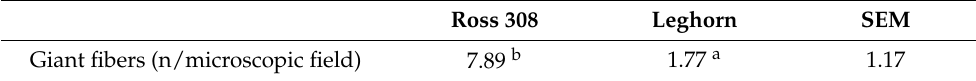
Table 4. Average number of giant fibers for different chicken strains.